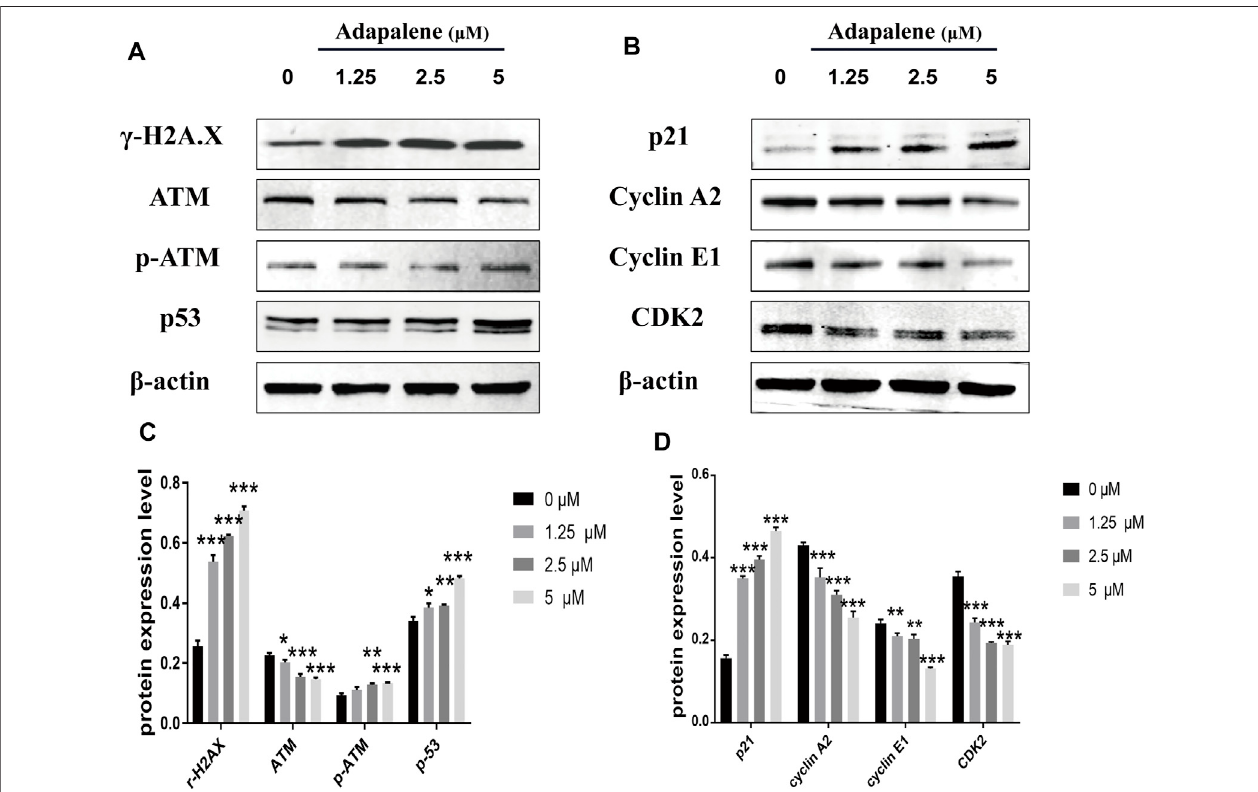
FIGURE 5 | ADA triggered a signi fi cant DNA damage pathway/p53/p21 in RM-1 cells. RM-1 cells were treated with the speci fi ed dosages of ADA for 24 h. (A,B) The protein expressions of γ -H2A.X, ATM, p-ATM, p53, p21, Cyclin A2, Cyclin E1, and CDK2 were analyzed by western blotting, and (C,D) histograms showed the proteinquantitativeanalyses,and β -actinactedastheloadingcontrol.Thesamplesderivefromthesameexperimentandthatgels/blotswereprocessedinparallel.Data are articulated as mean ± standard deviation. (* p < 0.05; ** p < 0.01; *** p < 0.001 vs. control).